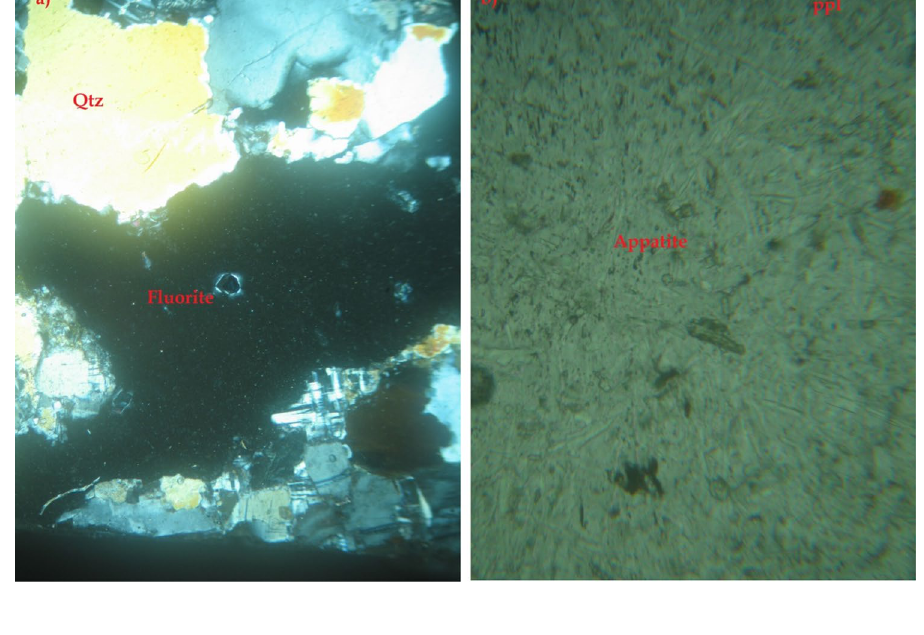
Fig. 10 Piper trilinear clas- sification of groundwater in pre and post-monsoon of the study